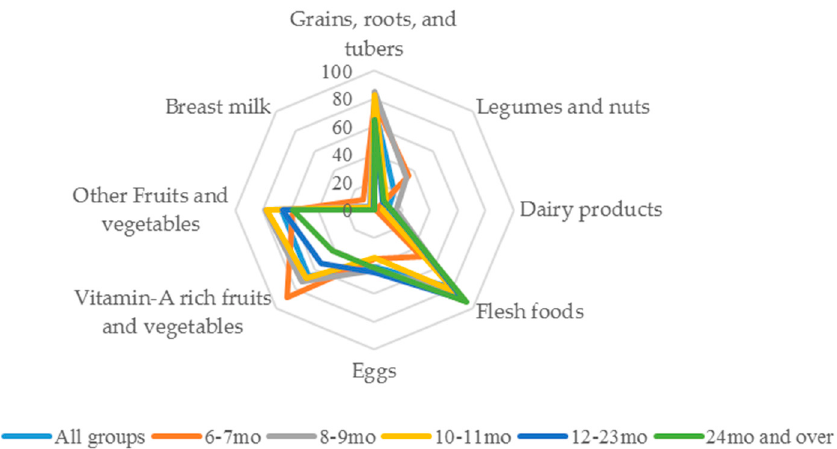
Figure 1. Trends of the percentages of food groups used in shared recipes across children’s age.